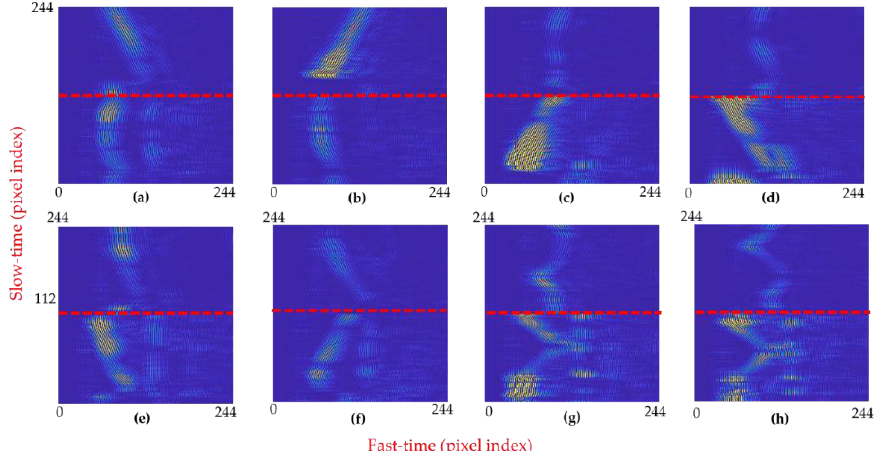
Figure 14. Image patterns of both radars for eight selected gestures. The red line separates data against radar-1 and radar-2.